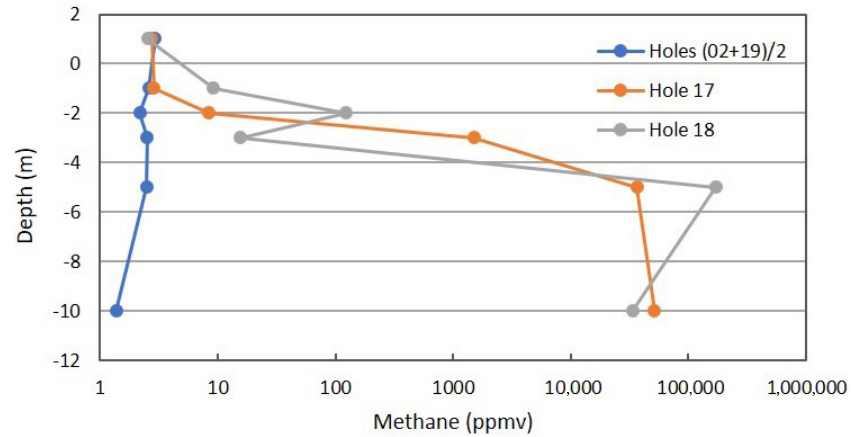
Figure 7. Methane profile for combined background locations and Locations 17 and 18 on Fault Zone